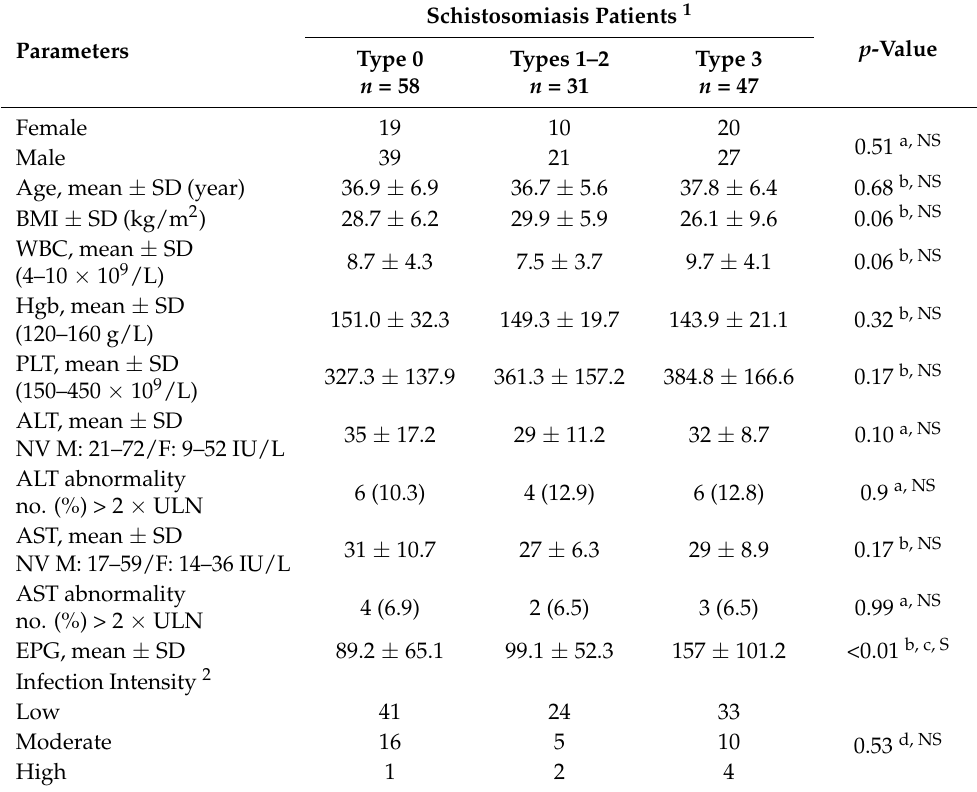
Table 1. Baseline characteristics of the 136 patients enrolled in the prospective study.